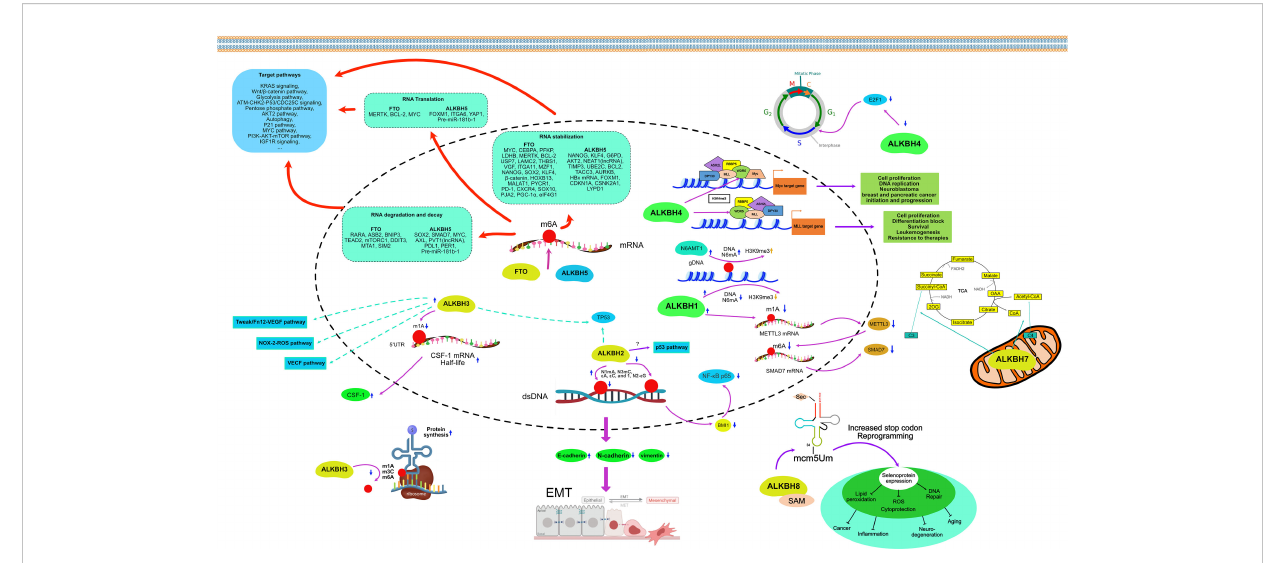
FIGURE 5 Mechanism of AlkB homologs in the regulation of